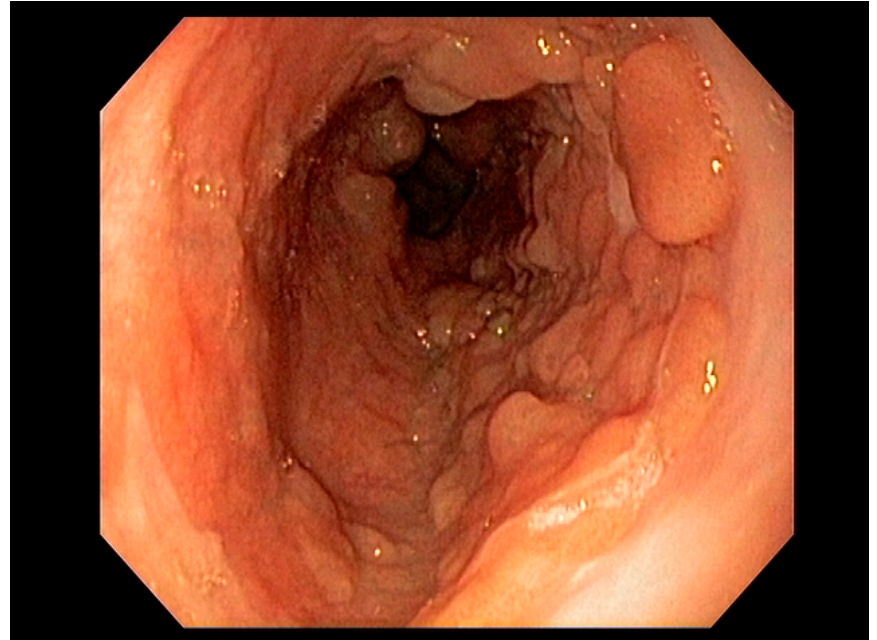
Figure 1. Barrett’s esophagus with Nodules White Light Endoscopy.